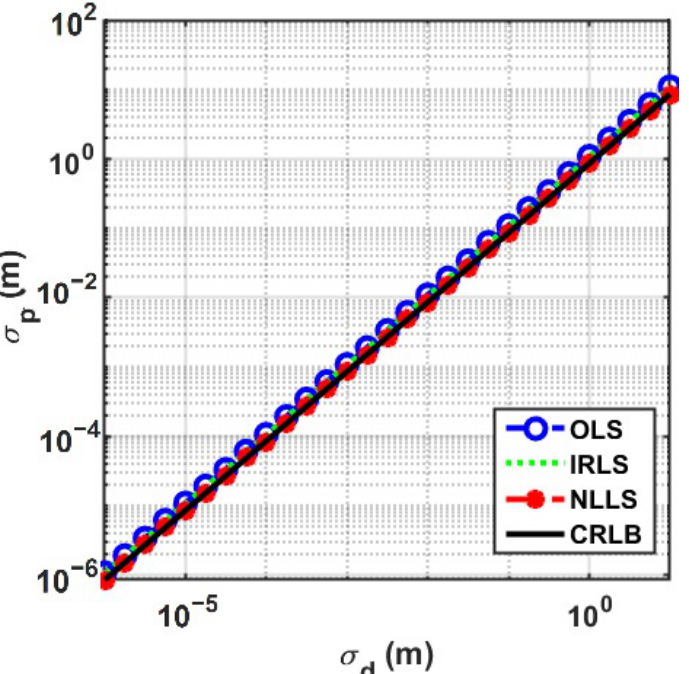
Figure 6. Performance comparison of the OLS, IRLS, and NLLS position estimators vs. the proposed 3D CRLB for N = 50 sensing elements. This demonstrates that the proposed CRLB is tractable for a massive number of elements and closely aligns with well-known